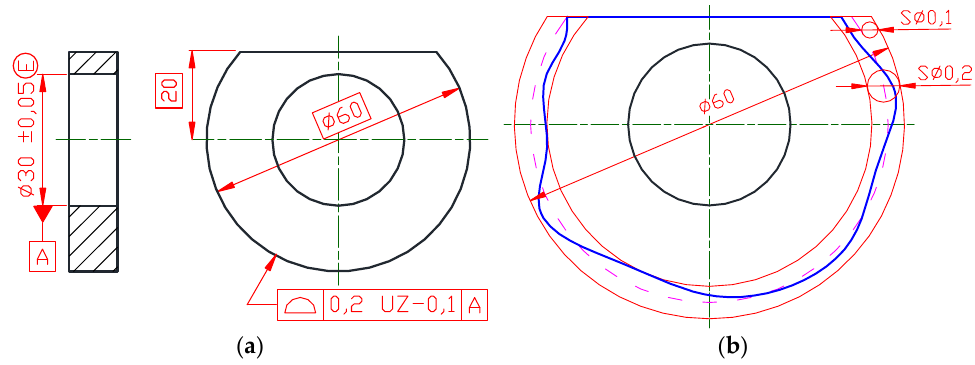
Figure 20. ( a ) The ISO GPS system specification equivalent to the requirement given in Figure 19a; ( b ) establishment of the tolerance zone according to the ISO GPS system, new offset theoretically exact feature is marked by the dashed line.